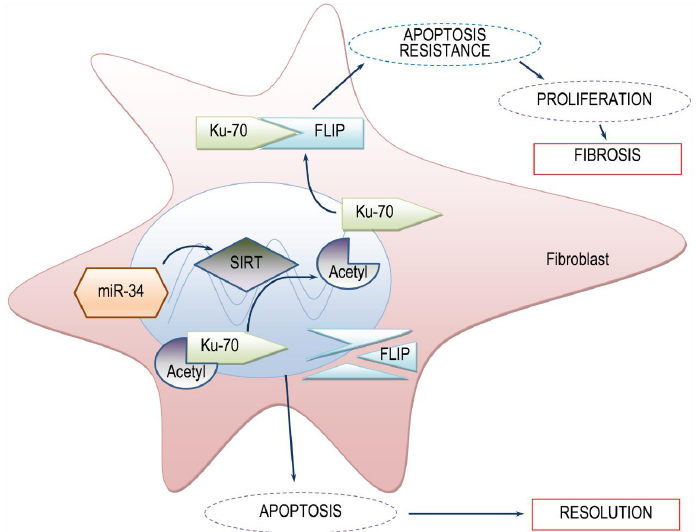
Figure 5. Simplified scheme of the proposed model SIRT1-mediated FLIP regulation during lung fibrosis. In the presence of SIRT1, low levels of acetylated Ku70 are detected. Deacetylated-Ku70 form complexes with FLIP, stabilizing FLIP. Increased FLIP, increases fibroblast resistance to apoptosis and fibrosis occurs. On the other hand, when SIRT1 is absent, Ku70 is in an acetylated state, cannot form complexes with FLIP, FLIP is destabilized, leading to fibroblast apoptosis and subsequent fibrosis resolution. miR34a mimic, may be a candidate for SIRT1 regulation.